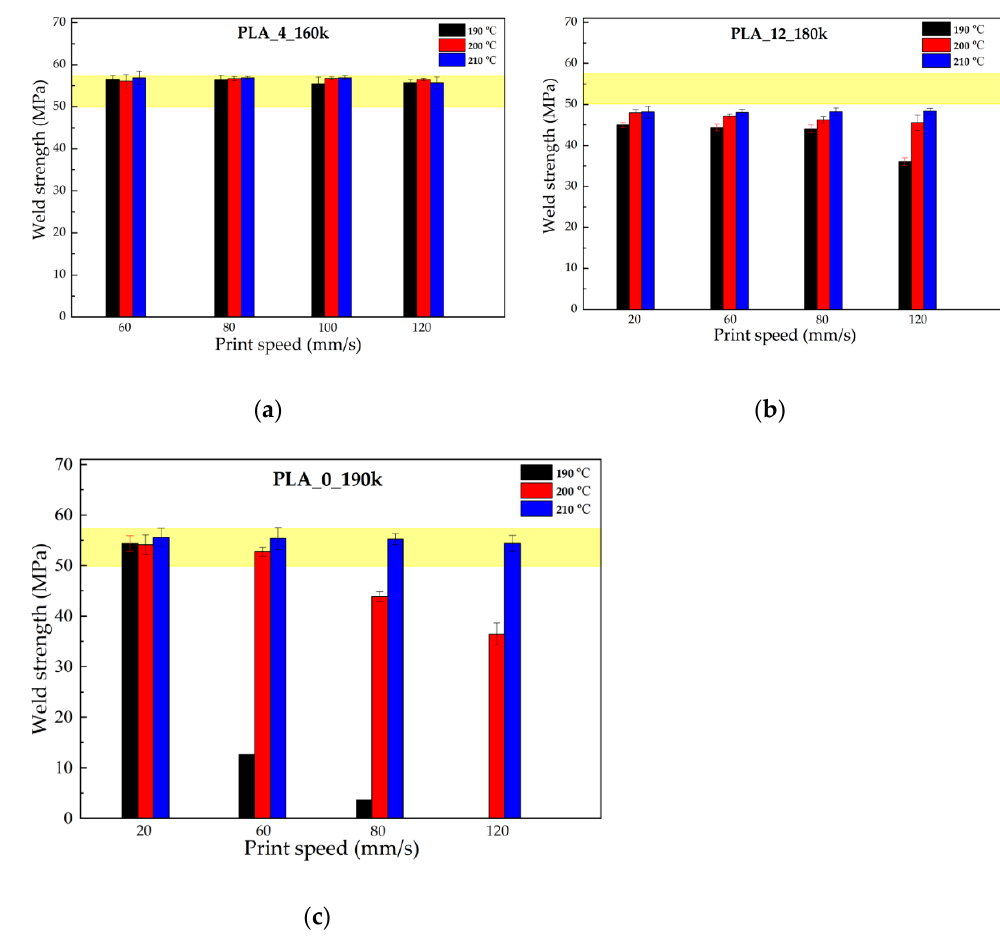
Figure A1. Weld strength as a function of different printing conditions for ( a ) PLA_4_160k, ( b ) PLA_12_180k and ( c ) PLA_0_190k.